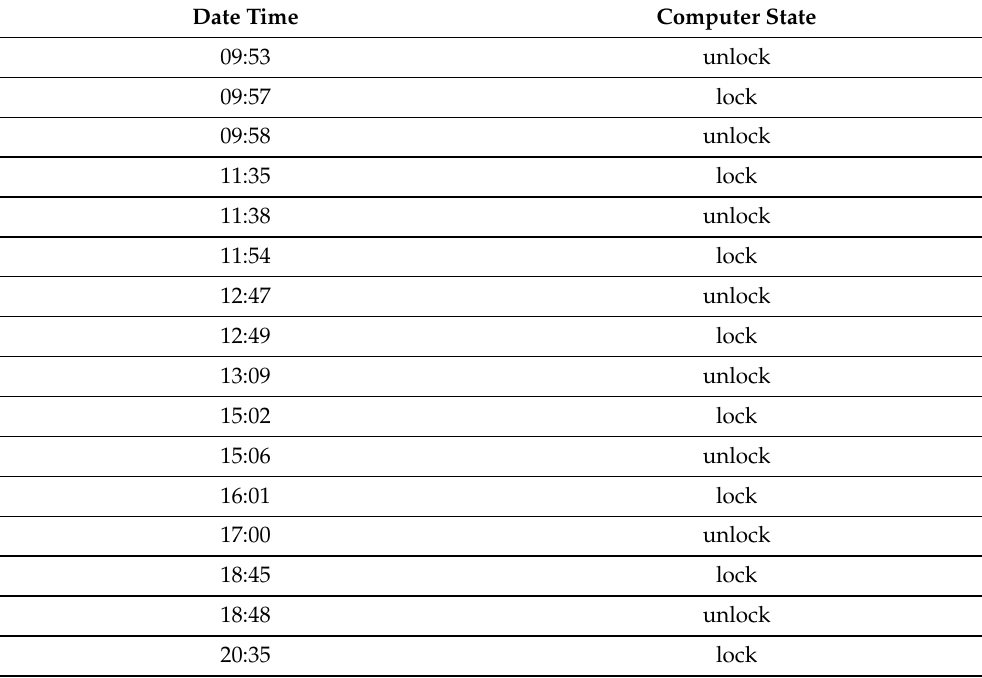
Table 4. Computer log registry from a user